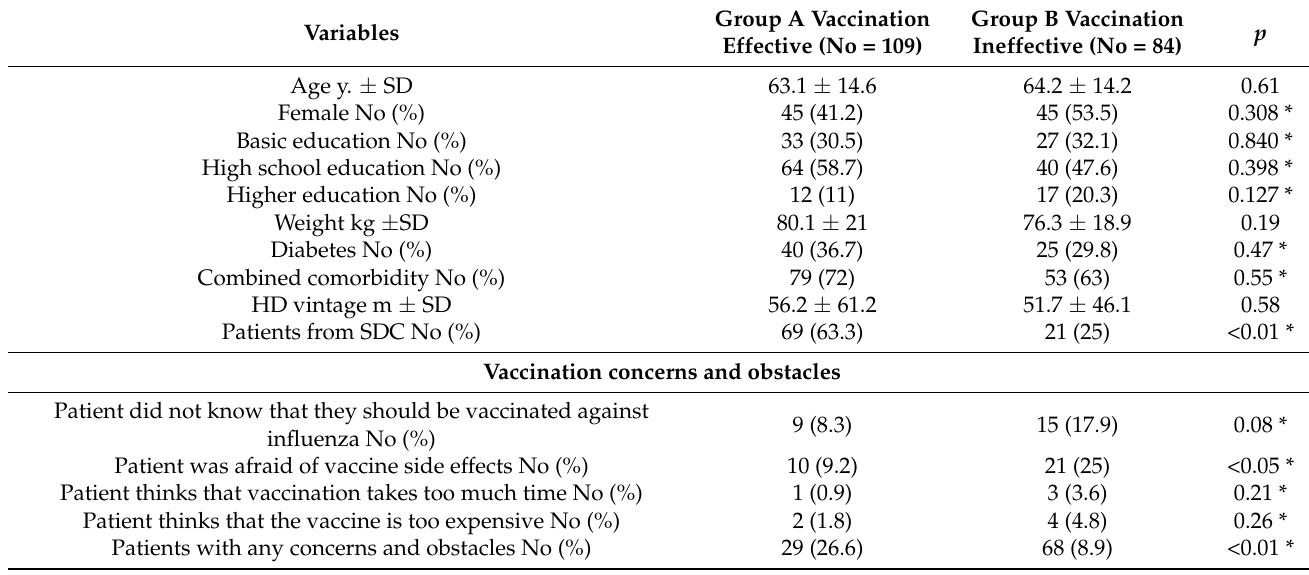
Table 5. Comparison of two groups of subjects (patients who believe vaccination is effective (Group A) and patients who believe vaccination is ineffective (group